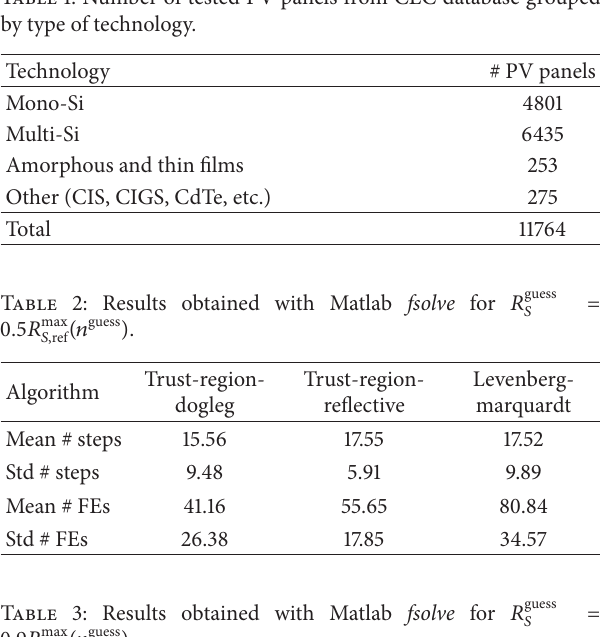
Table 3: Results obtained with Matlab fsolve for 𝑅 guess 𝑆